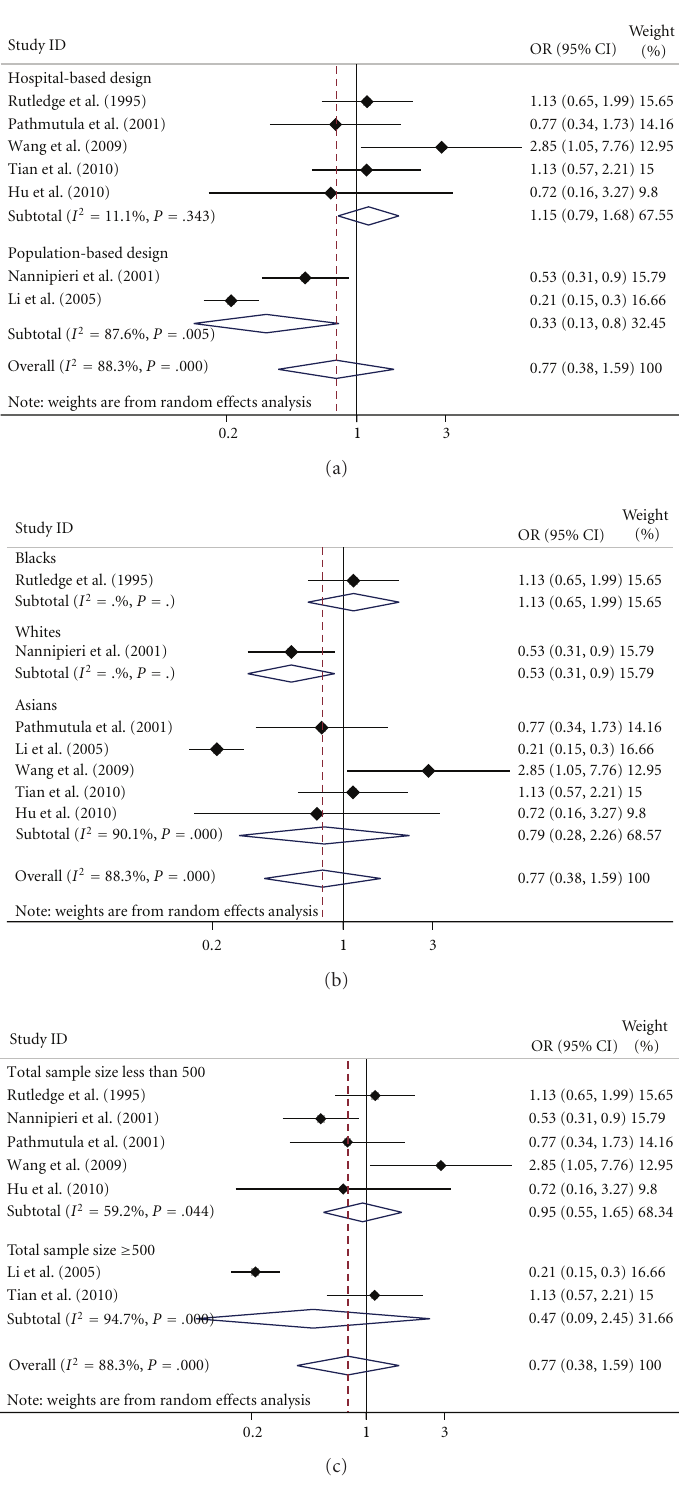
Figure 4: Subgroup analysis of ANP gene T2238C polymorphism with hypertension by study design (a), ethnicity (b), and sample size (cuto ff : 500 individuals) (c) in the allelic